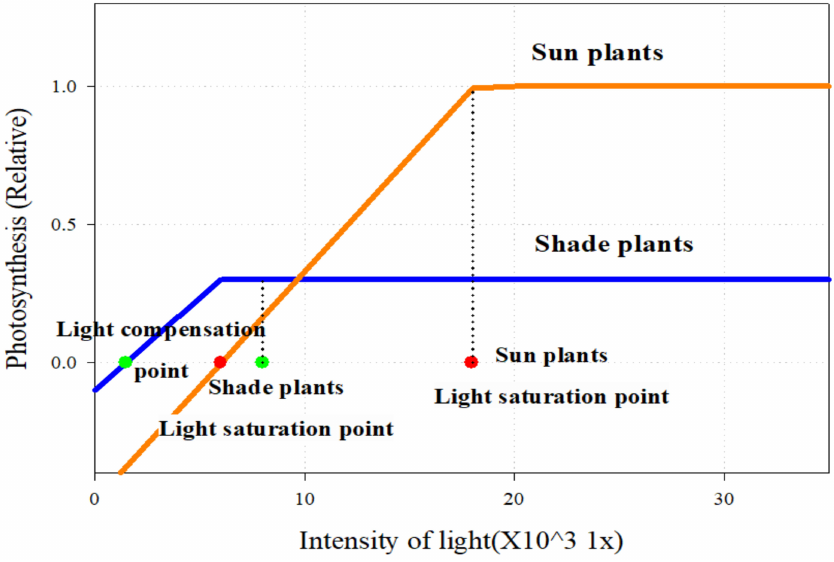
Figure 3. Light compensation point and light saturation